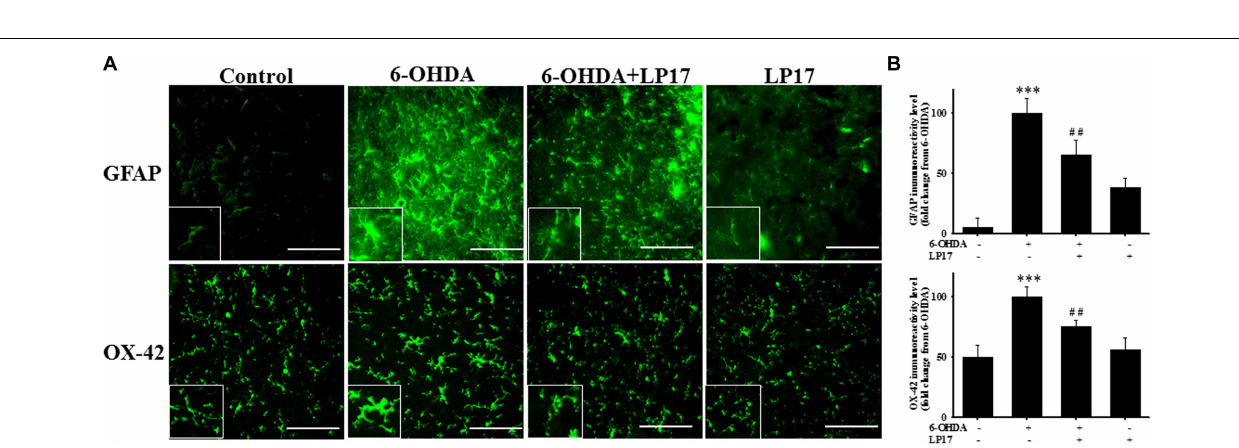
FIGURE 9 | Treatment with LP17 attenuated the 6-OHDA-induced upregulation of OX-42 and GFAP expression in a rat model of PD ( n = 5/group). (A) Analyses of GFAP and OX-42 immunoreactivity at 14 days after the development of lesions in the 6-OHDA group and the 6-OHDA plus LP17 group after treatment with either the control peptide or 40 µ g/kg LP17 (1 µ g/ µ l for a 10- µ l solution) plus 5 µ g 6-OHDA. The results showed that LP17 significantly attenuated 6-OHDA-induced increases in GFAP and OX-42 expression. (B) Quantitative results of immunoreactivity analyses for GFAP and OX-42 expression at 14 days after the development of lesions in the control, 6-OHDA, 6-OHDA plus LP17, and LP17-only groups. LP17 significantly decreased 6-OHDA-induced GFAP and OX-42 upregulation (scale bar = 25 µ m). The bars represent means ± SEM. The data were analyzed using two-way ANOVA. ∗∗∗ P < 0.001 versus the control group; ## P < 0.05 versus the 6-OHDA